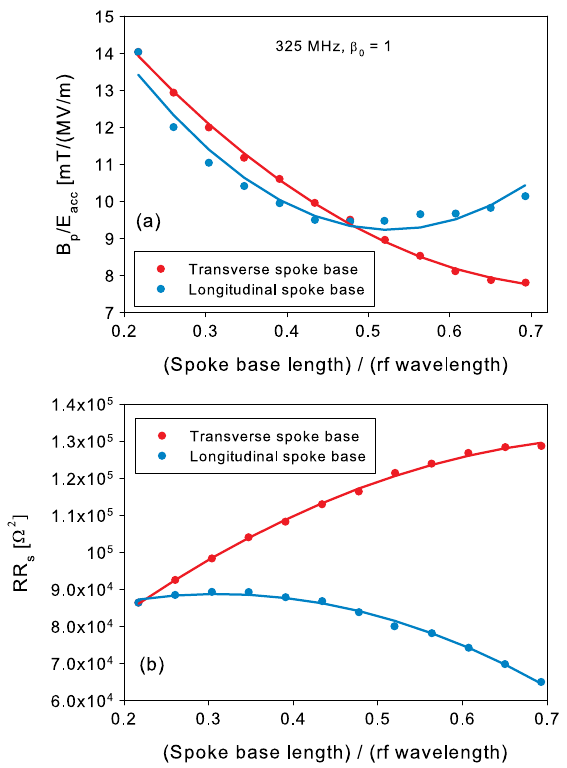
FIG. 5. (a) Dependence of B p =E acc and (b) RR s on spoke base length normalized to rf wavelength for a 325 MHz, (cid:1) 0 ¼ 1 double-spoke cavity at a constant base width of 200 mm. The blue curves represents a longitudinal base geometry, while the red curves are for an identical spoke base, but oriented transversely to the beam line. In both plots, the leftmost point is common to both curves since it represents a cylindrical spoke